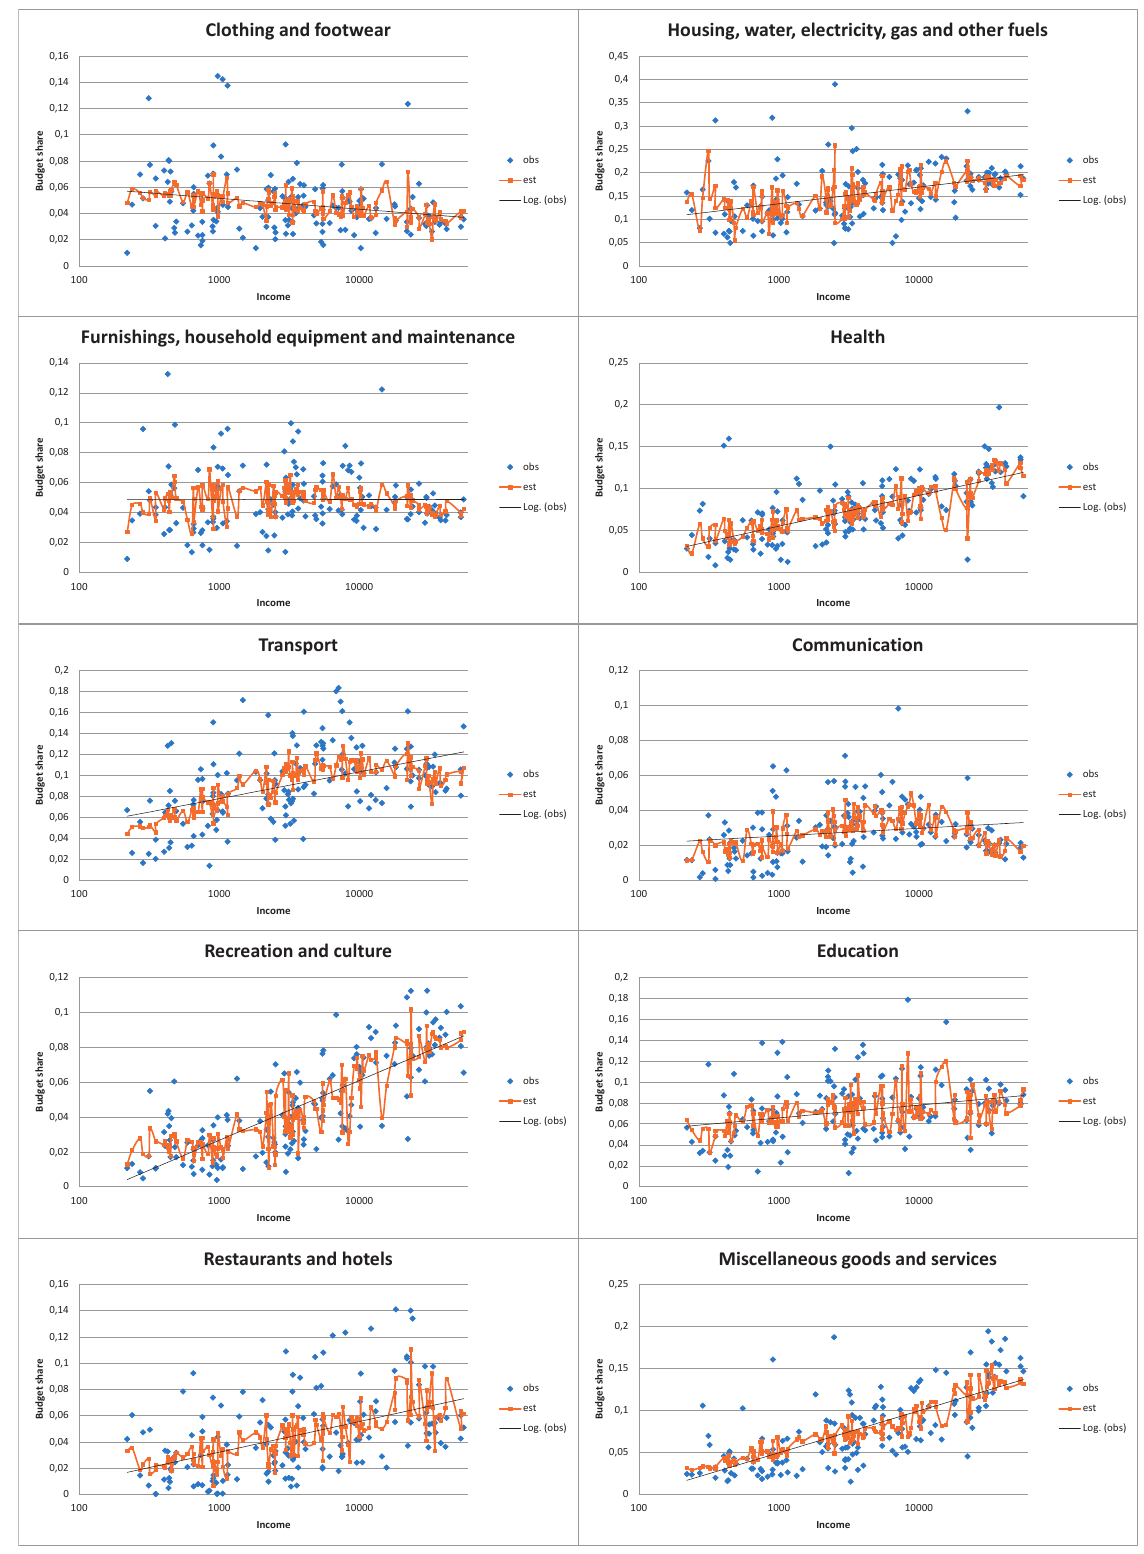
Figure 1. Scatter plots, Non-Food